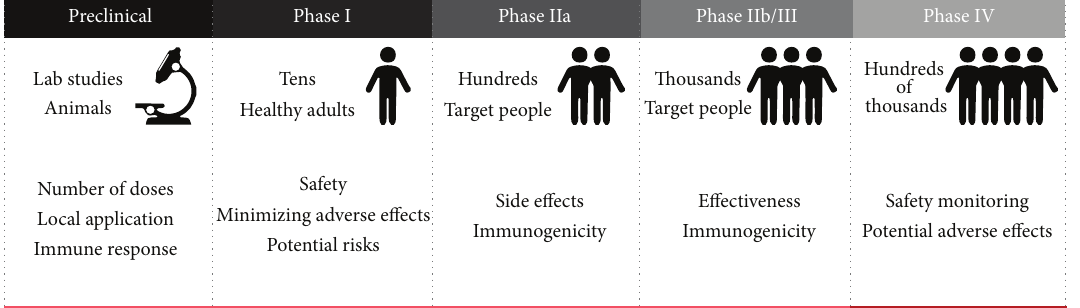
Figure 3: The different stages of vaccine